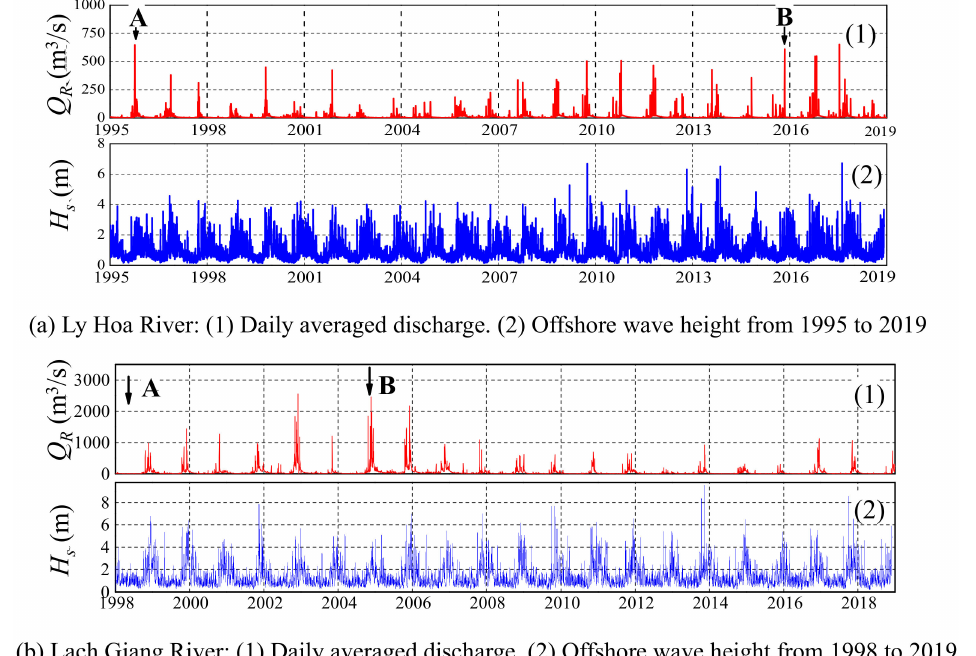
Figure 2. Hydrodynamic conditions at ( a ) Ly Hoa River and ( b ) Lach Giang